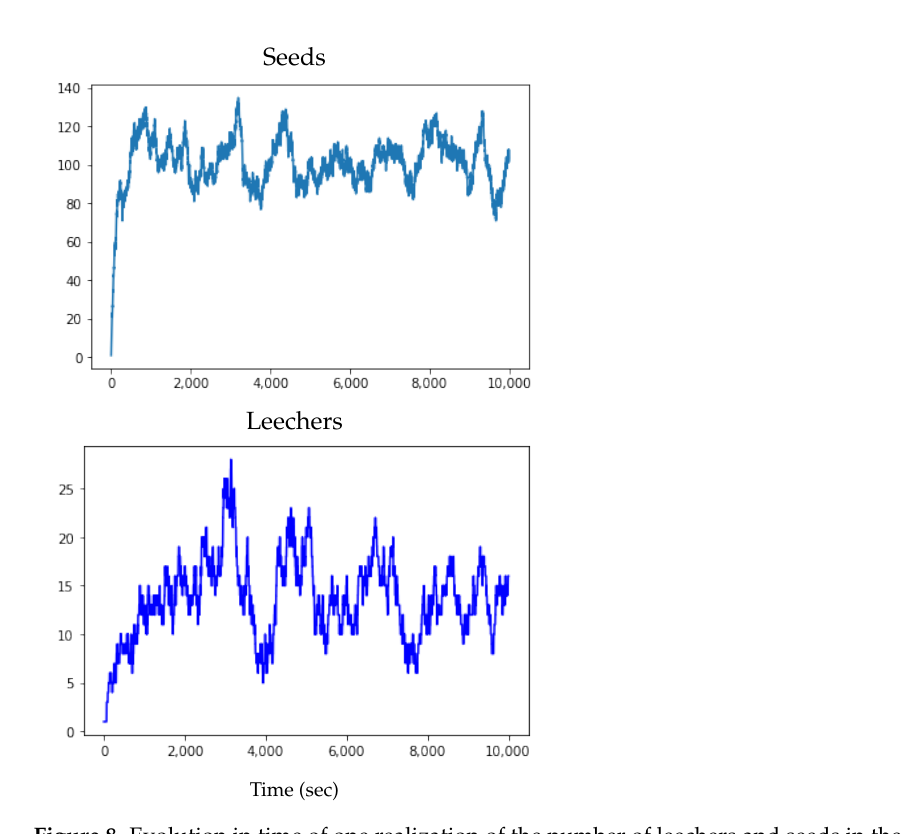
Figure 8. Evolution in time of one realization of the number of leechers and seeds in the system. For this experiment, the average number of leechers obtained was 100, and the average number of seeds was 16, as shown in Table 4. Table 4. Averages and simulation time of the simple Markov chain for each type of